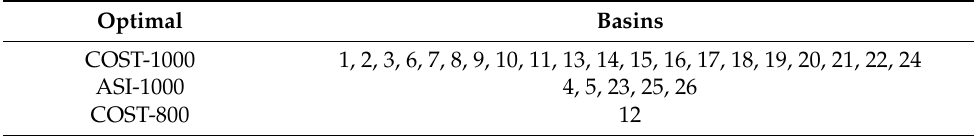
Table 7. The results of each basin about the optimal filtering radius.